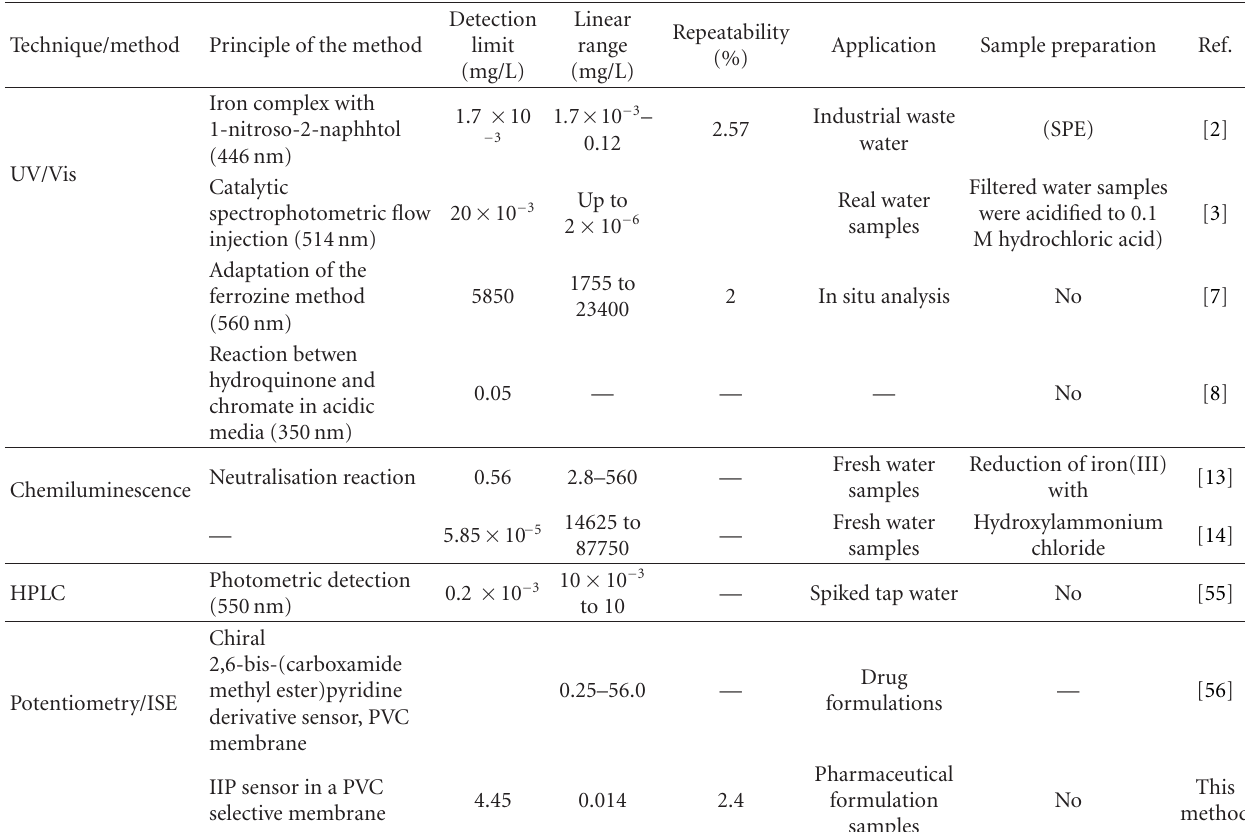
Table 3: Analytical features of the present method reported in the